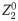
RMS defocus (Z20) values of the designed IOLs for misalignment (left column) and tilt (right column) with each different cornea: A) Normal, B) Myopic, C) Hyperopic.